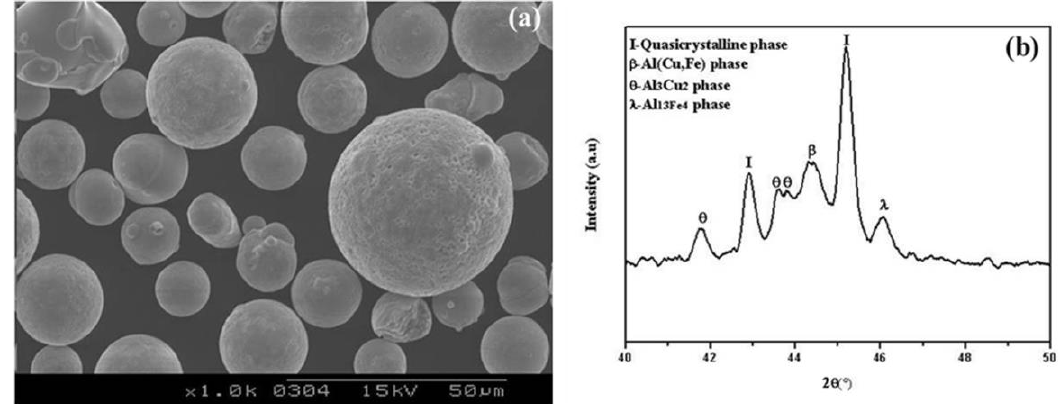
Figure 1. ( a ) SEM morphology and ( b ) XRD results of gas-atomized Al 50 Cu 20 Fe 15 Si 15